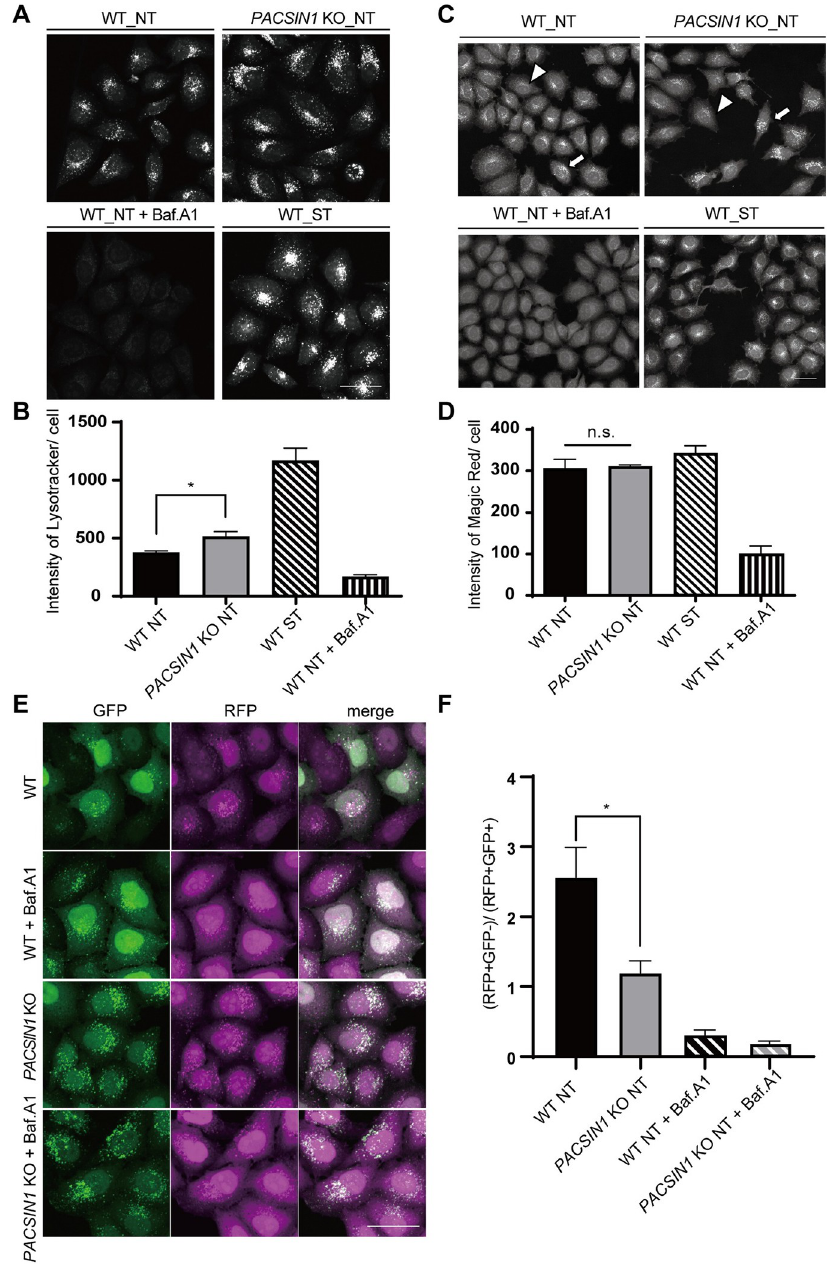
Fig 2. PACSIN1 is required for the autophagosome-lysosome fusion process but not for lysosomal function. (A) WT or PACSIN1 KO HeLa cells were cultured for 2 h in growth medium or starvation medium containing 50 nM Lysotracker Red with or without 125 nM Baf.A1. Cells were fixed and then analyzed using CQ1 software. Scale bars, 40 μ m. (B) Quantified and normalized Lysotracker mean intensity per cell, mean ± s.e.m. More than 100 cells were analyzed per condition in each experiment (n = 3). � p < 0.05 (two-tailed, unpaired t-test). (C) WT or PACSIN1 KO HeLa cells were cultured for 2 h in growth medium or EBSS with or without 125 nM Baf.A1 and treated with Magic Red. After fixation, cells were analyzed using CQ1 software. The cell exhibited relatively high and low intensity of Magic Red were indicated by arrows and arrowheads, respectively. Scale bars, 40 μ m. (D) Quantified Magic Red mean intensity normalized per cell, mean ± s.e.m. More than 100 cells were analyzed per condition in each experiment (n = 3). n.s.; not significant (two-tailed, unpaired t-test). (E) WT or PACSIN1 KO HeLa cells stably expressing tf-LC3 were cultured for 2 h in growth medium with or without 250 nM Baf.A1. After fixation, cells were analyzed using CQ1 software. Scale bars, 40 μ m. (F) The numbers of RFP+GFP − /RFP+GFP+ dots were counted, mean ± s.e.m. More than 100 cells were analyzed per condition in each experiment (n = 3). � p < 0.05 (two-tailed, unpaired